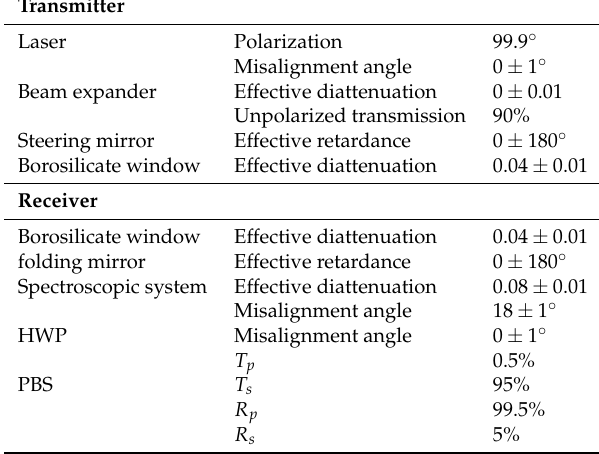
Table 3. List of polarization-affected parameters for all main parts of the LiDAR system. Misalignment angles and the diattenuation of the borosilicate window (tilted for 30 ◦ with respect to the optical axis of the telescope) were estimated by dedicated measurements. Other parameters were estimated based on the data provided by the manufacturers of the corresponding components, which are listed in Tables 1 and